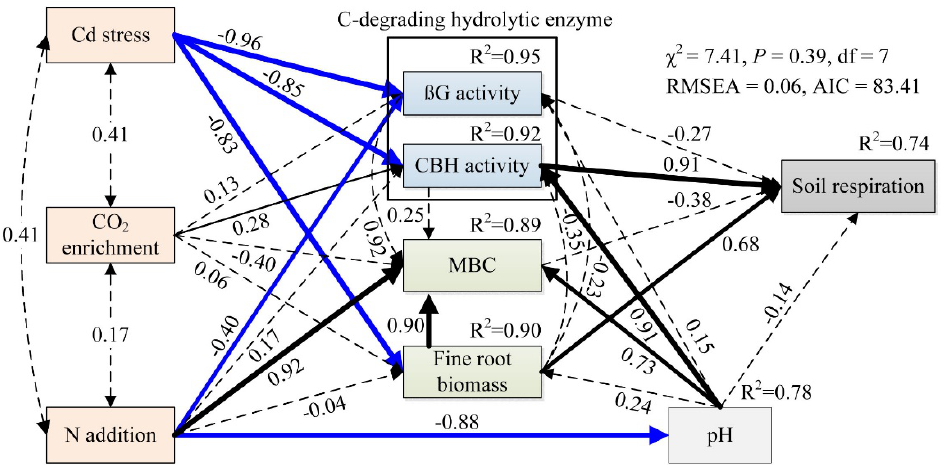
Figure 6. Relationships between annual litterfall production ( a ), fine root biomass ( b ), and mean annual soil respiration.